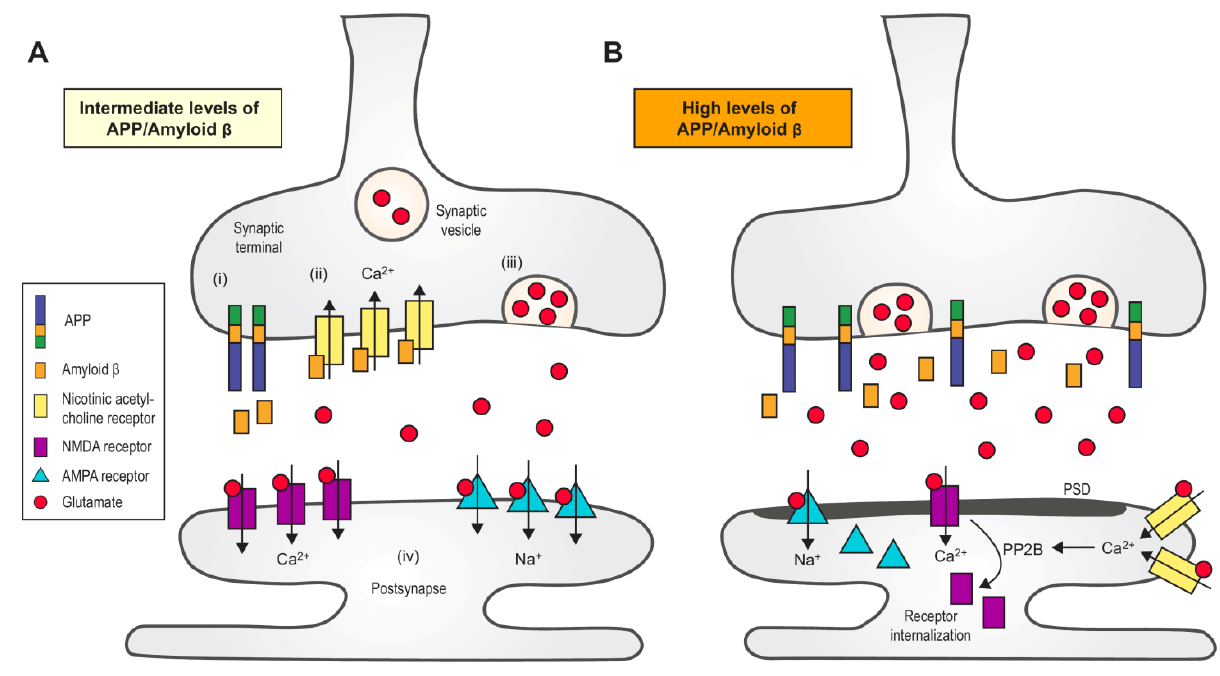
FIGURE 2: Synaptic transmission regulated by amyloid  (Aβ). (A) An intermediate increase in A  level can only increase the probability of releasing synaptic vesicles. The processing of amyloid precursor protein (APP) at the synaptic terminal yields A  peptides (i), which bind to and activate the presynaptic  7-nAChRs (ii). Moreover, the subsequent influx of Ca 2+ is mediated by nAChRs, which, in turn, trig- ger the release of glutamate from the synaptic vesicles (iii). Glutamate activates both AMPARs and NMDARs, which induce synaptic po- tentiation (iv). (B) A dramatic increase of A  , however, can lead to LTD. First, accumulation of glutamate results in the long-term activa- tion of NMDARs and AMPARs, which facilitates their internalization. Second, A  might redistribute NMDARs. Third, the activation of peri- synaptic  7-nAChRs activates the protein phosphatase 2B (PP2B), a Ca 2+ -sensitive enzyme that induces the internalization of NMDARs [67].  7-nAChR,  7-nicotinic acetylcholine receptor. PSD, post-synaptic density . NMDAR, N-methyl-D-aspartate receptor. AMPAR, α- amino-3-hydroxy-5-methyl-4-isoxazolepropionic acid